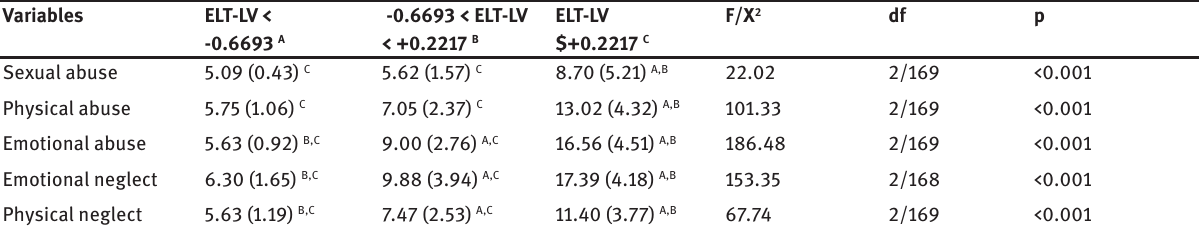
Table 1: Measurements of five early life trauma (ELT) in subjects divided into high, medium and low values of ELT-latent vector (LV) scores. Variables